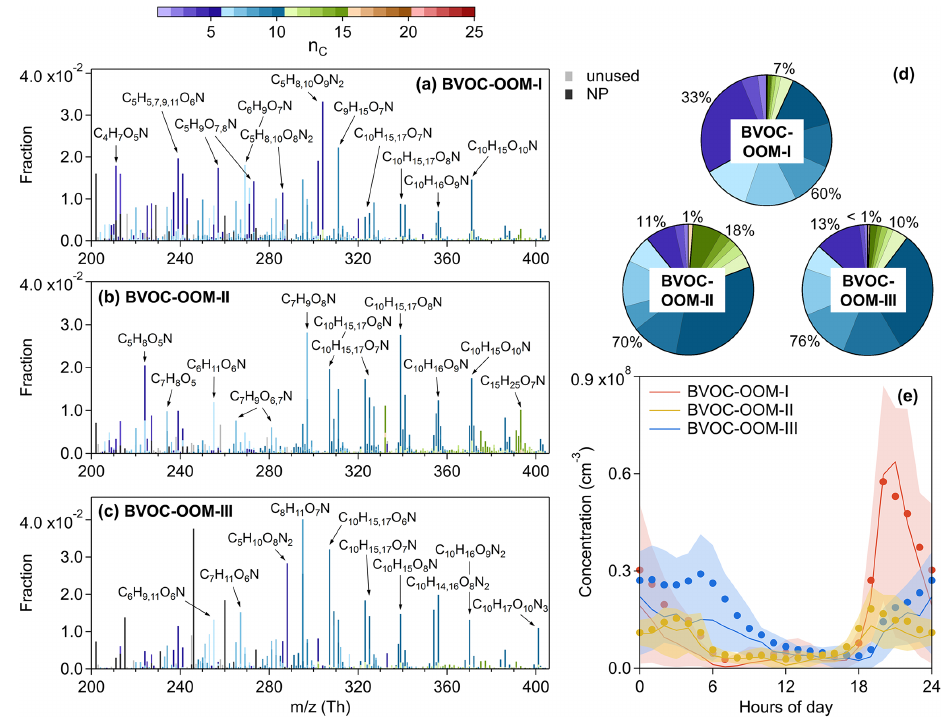
Figure 9. Mass spectra of (a) the BVOC-OOM-I factor, (b) the BVOC-OOM-II factor, and (c) the BVOC-OOM-III factor, and the elemental formulas of major peaks are labeled above them. Peaks are color-coded by n C as indicated at the top of the figure, and the fractions of peaks grouped by n C are reported in (d) the pie charts. The gray bars are fluorinated contaminations or non-identified compounds. The nitrated phenols are drawn separately with black peaks in (a) – (c) . The molecules represented by the gray and black bars were not included in (d) . Diurnal patterns of these three factors are shown in (e) : the bold solid lines are the median values; shaded areas represent percentiles of 75% and 25%; and solid circles represent mean